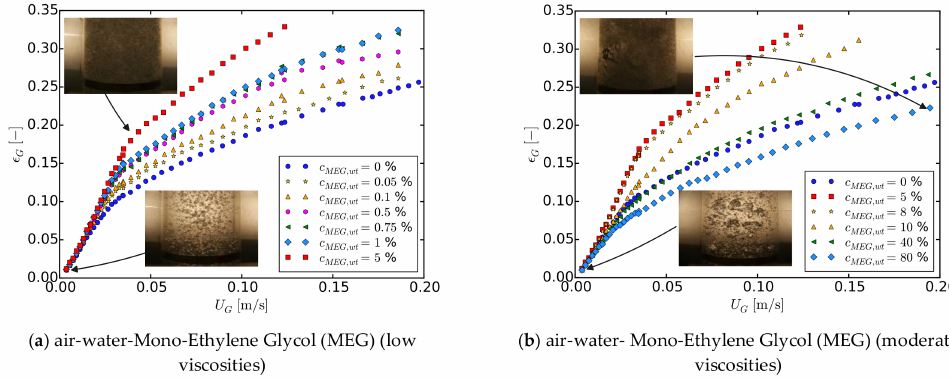
Figure 22. Flow regime